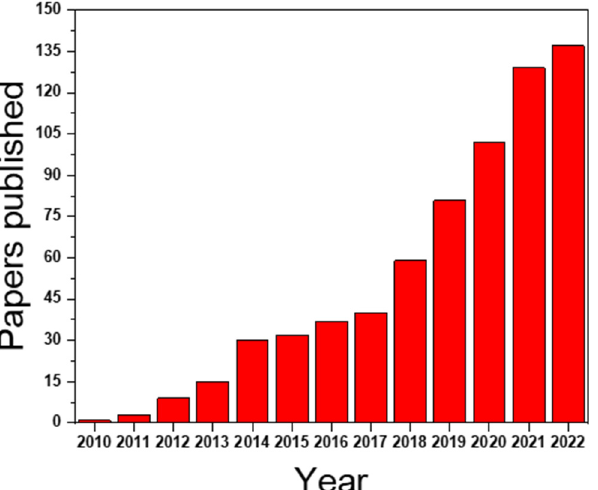
Figure 1. Number of papers published about the biosynthesis of ZnONPs in the last years. Data analysis performed on Scopus ® using “Biosynthesis”, “Zinc oxide” and “Nanoparticles” as